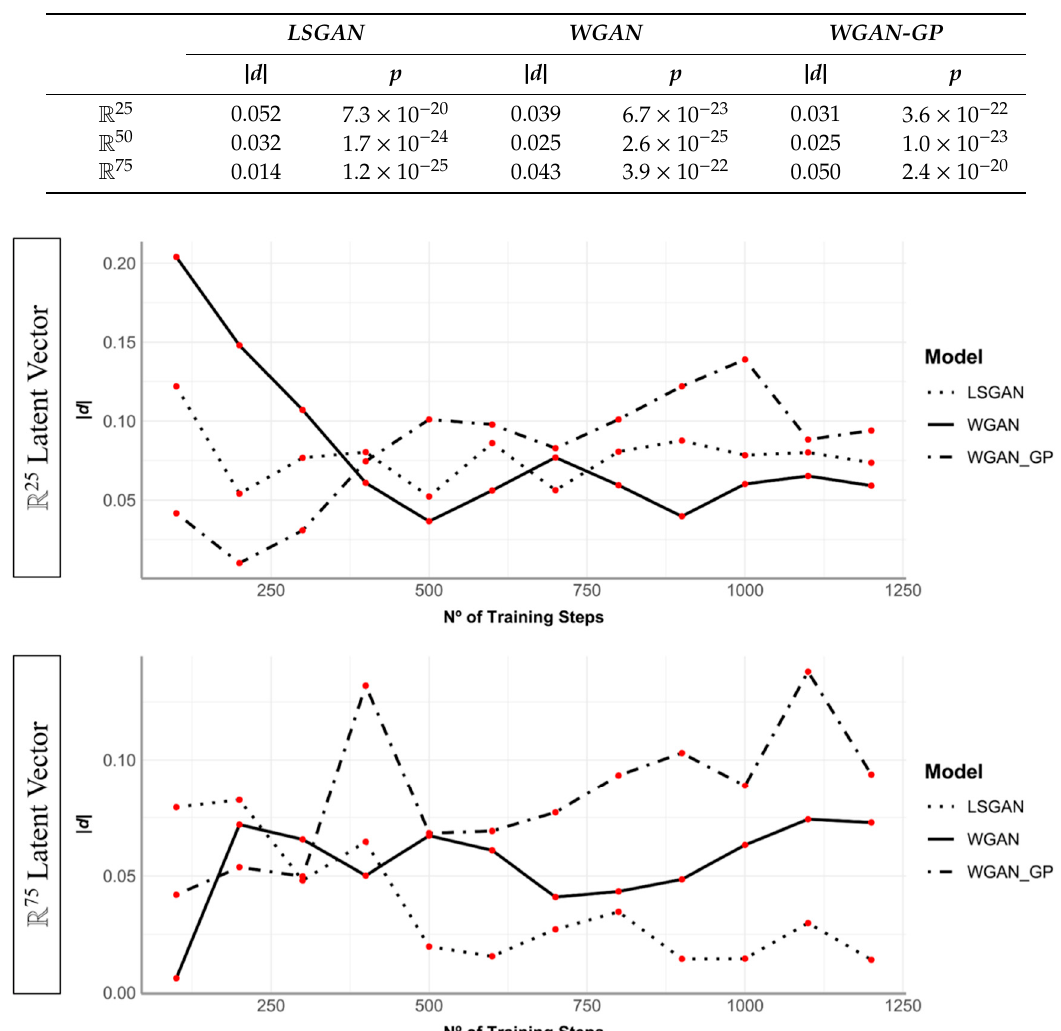
Figure 5. rTOST absolute di ff erence values obtained comparing synthetic data generated over multiple training steps with the original distribution (example of DS3). Upper and lower panels compare di ff erent GANs using di ff erent sized latent vector inputs to the generator. GANs were trained for 400 epochs with batch sizes of 16. Here 3 training steps are considered an epoch.